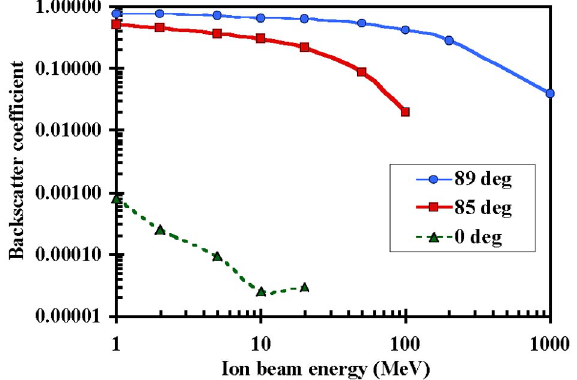
FIG. 4. (Color) Fraction of K (cid:6) ions that scatter off of stainless steel versus ion energy at three selected angles, computed by the SRIM code.